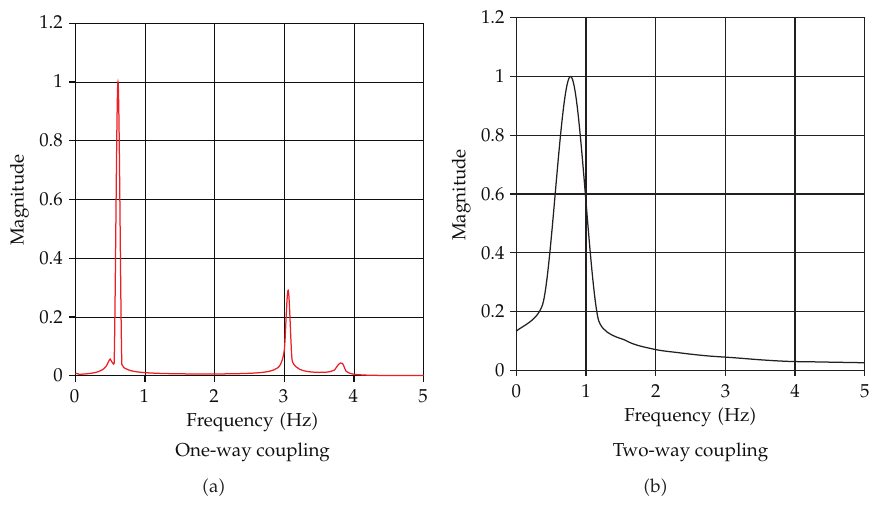
Figure 6: Frequency spectrum, v (cid:8) 0 . 27m/s, plate 2.